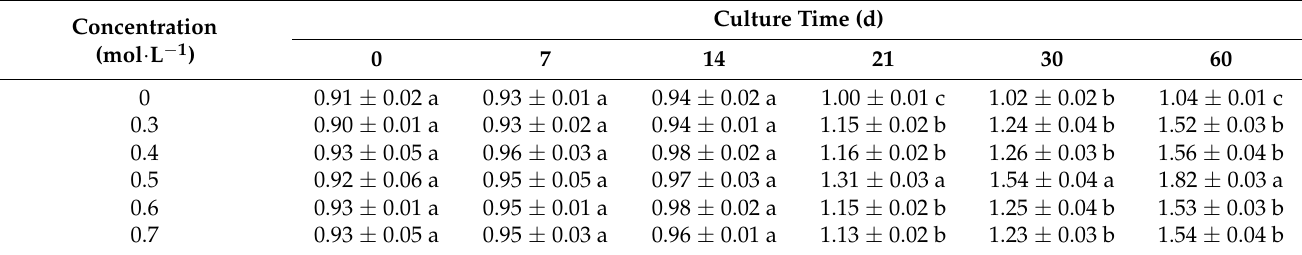
Table 1. Effect of sucrose concentration on EC fresh weight of F. mandshurica after cryopreservation by